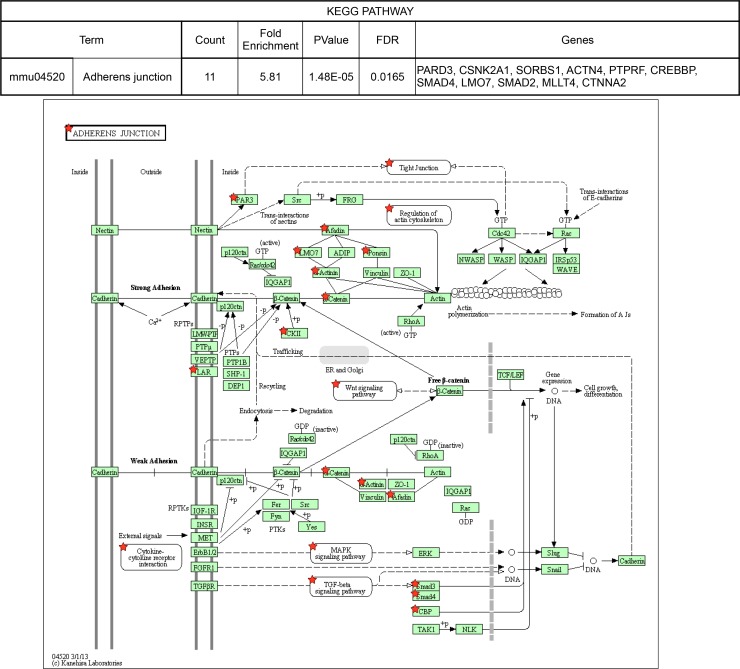
KEGG pathways over-represented among NOVA2-target genes.Adherens junction pathway (FDR<0.05). Red stars indicating NOVA2-target alternative splicing genes identified by combining RNA-seq with NOVA2 HITS-CLIP analysis. Figures obtained from GO analysis using DAVID Bioinformatics Resources (https://david.ncifcrf.gov).